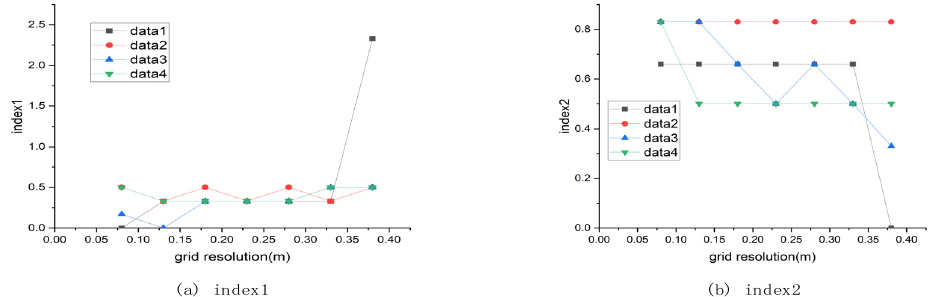
Figure 10. The effect of cloth mesh resolution on the results.